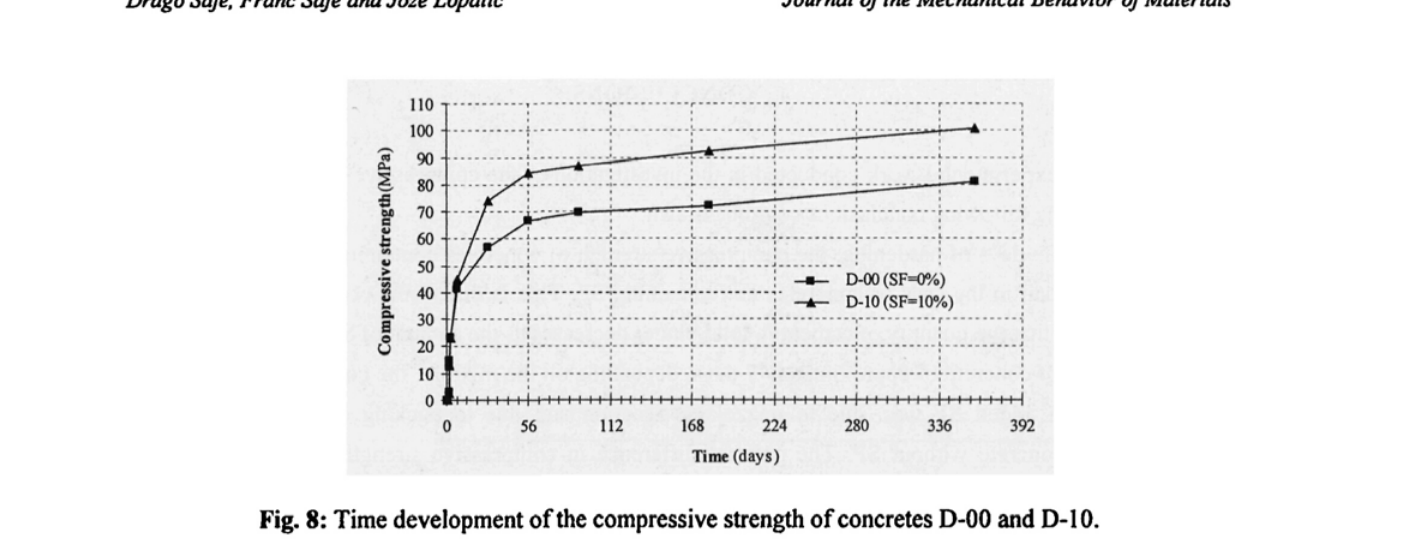
Fig. 8: Time development of the compressive strength of concretes D-00 and